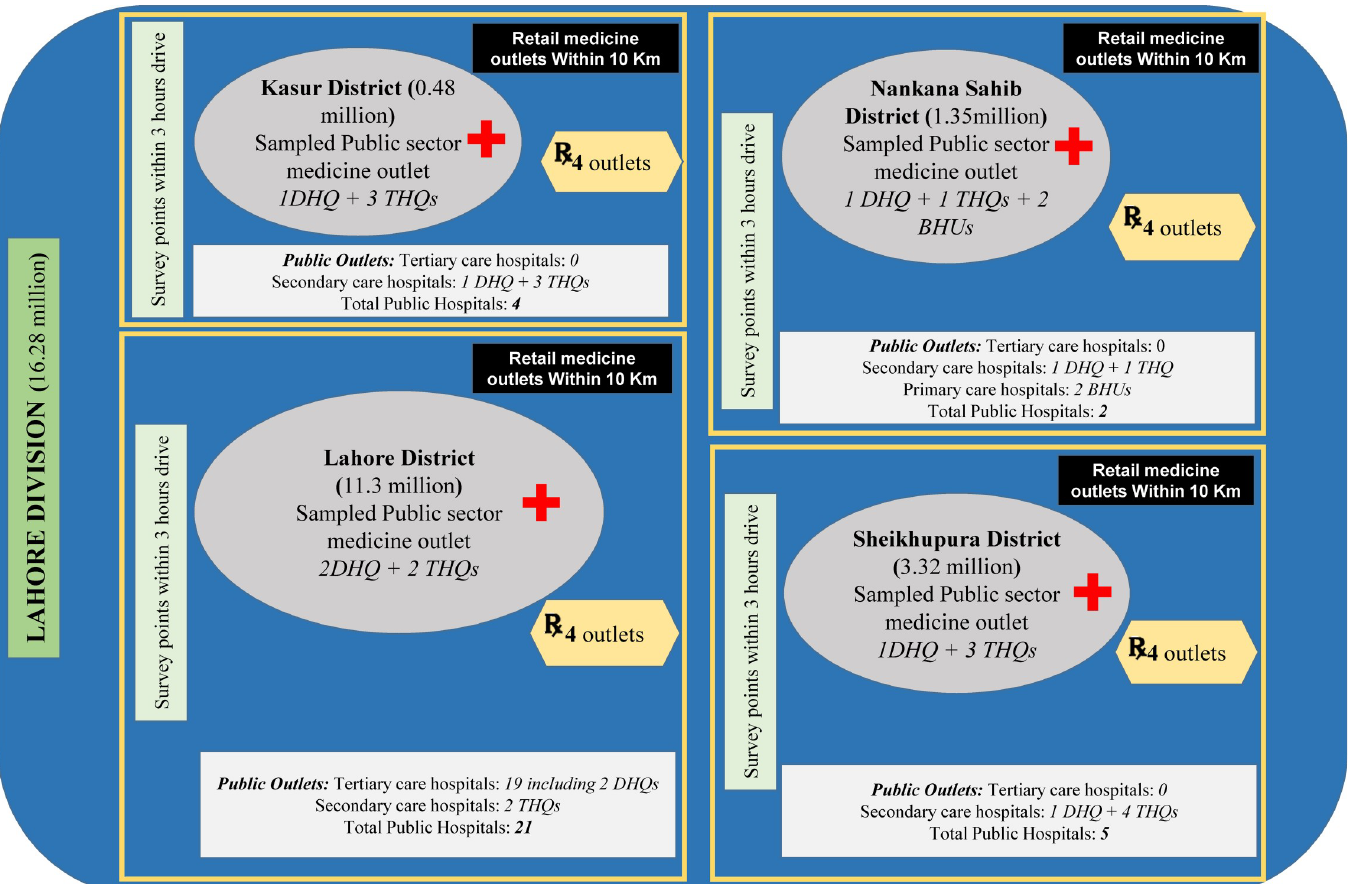
Fig 1. Macrograph depicting sampling sectors of the study along with district wise distribution of population, total hospitals and sampled public sector medicine outlets. DHQ; district head quarter hospital, THQ; tehsil head quarter hospital and BHU; basic health unit. In Lahore district, 2 Tertiary care hospitals are given the status of DHQ, one of these DHQs was taken as survey anchor. The Red Cross symbol indicates a public sector medicine outlet and the prescription symbol indicates a private sector medicine outlet.